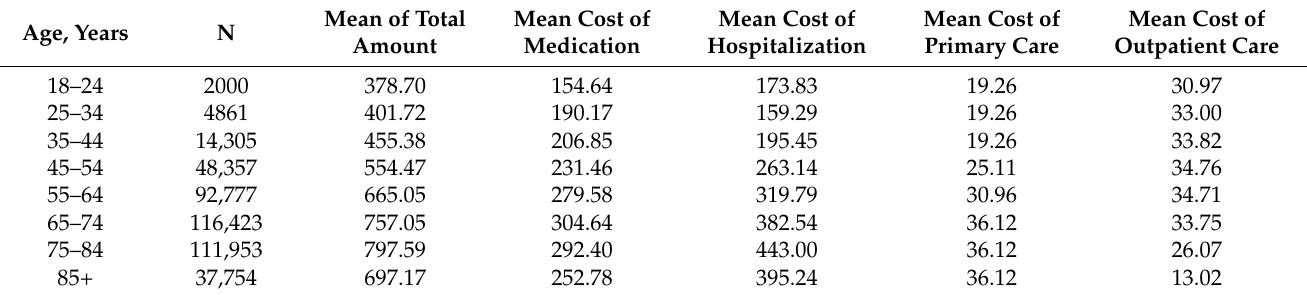
Table 2. The annual cost of a patient with multimorbidity in EUR in different age groups.